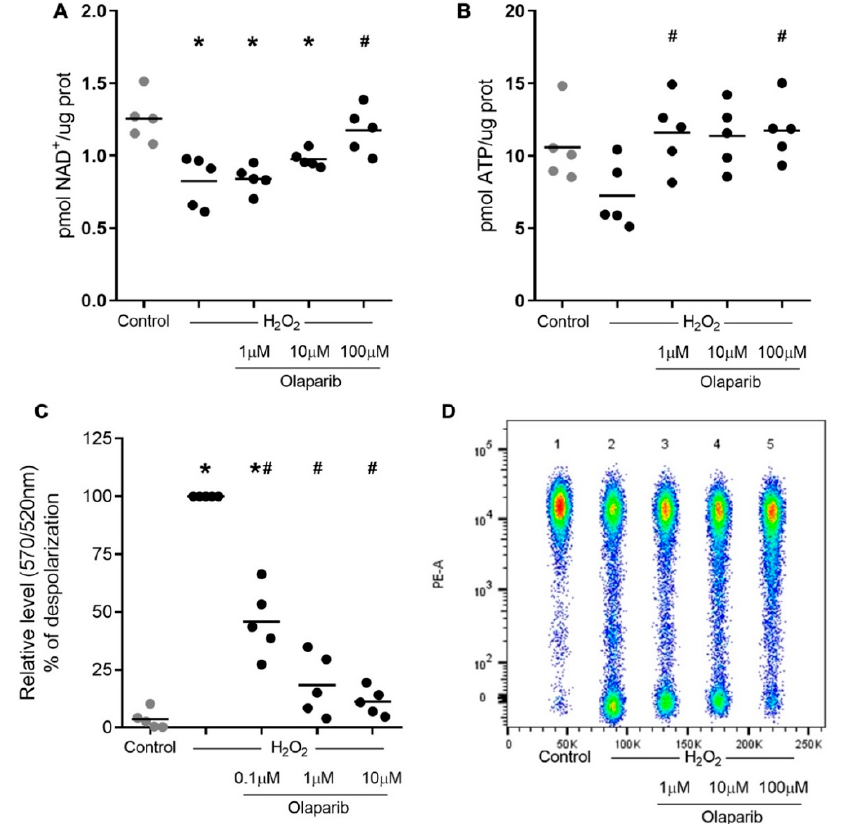
Figure 3. Effect of olaparib on NAD + and ATP levels of human PBMCs exposed to oxidative stress. PBMCs from five healthy volunteers were incubated for 4 h with increasing concentrations of olaparib (1–100 µM) and in the presence of H 2 O 2 (250 µM) for 2 h. Protein was extracted, and NAD + ( A ) and ATP ( B ) levels were quantified by colorimetric and fluorometric assays, respectively. Values are expressed in pmol NAD + or ATP/ug protein. Mitochondrial membrane potential (MMP) meas- urements ( C ) were conducted in lymphocytes; MMP is expressed as the FL-1/FL-2 GMFI ratio. ( D ) Dot plots representative of concatenating analyses from five individuals. * p < 0.01 compared to the control condition. # p < 0.05 compared to the H 2 O 2 condition. (ANOVA followed by Tukey’s test).